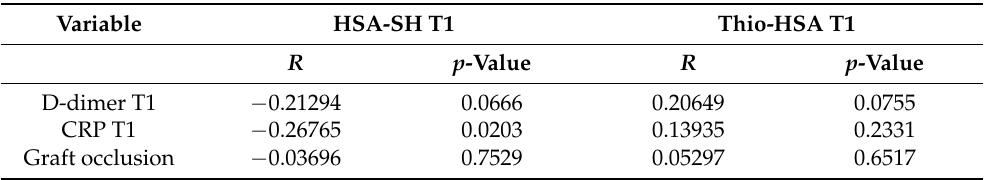
Figure 4. Changes in HSA-SH ( A ) and Thio-HSA ( B ) levels after surgery. p -Values are from Student’s t -test. Table 4. Spearman correlation for mercaptoalbumin (HSA-SH) and thiolated albumin (Thio-HSA) after surgery.